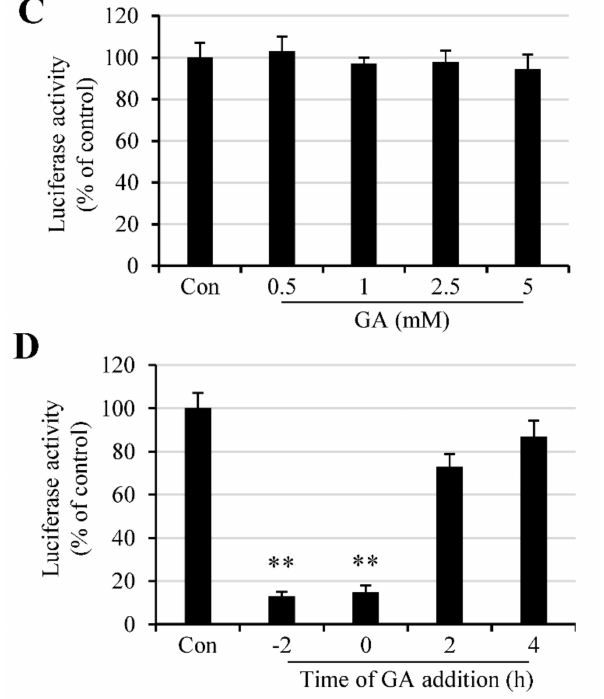
Figure 1. GA effect on Lenti-S infection. ( A ) Molecular structure of glycyrrhizic acid. ( B ) Effect of GA on Lenti-S infection. Vero E6 cells were infected with Lenti-S pseudovirus in the absence or presence of GA at indicated concentrations for 24 h. Luciferase activity was determined. Data are expressed as a percentage of untreated controls (Lenti-S). The experiment was performed twice, and data are mean ± SD of triplicate wells. Independent two-sample comparisons between non-GA treated sample and sample treated with GA at different concentrations, respectively, were determined by Student’s t test. ns: no significance; *, p < 0.05; **, p < 0.01. ( C ) Effect of GA on luciferase expression in pCMV-luc-transfected cells. Monolayers of 293T cells were transfected with pCMV-luc for 16 h. The cells were then treated with GA at indicated concentrations. Luciferase activity was determined after 24 h incubation. GA treatment did not affect luciferase expression delivered by an encoding plasmid. The experiment was performed twice. The readings from untreated samples were used as a control for the calculation of relative luciferase activity. Data are mean ± SD of duplicate wells from 2 independent experiments. ( D ) Time of GA addition on Lenti-S-mediated luciferase gene delivery. Vero E6 cells were untreated or treated with 3 mM GA at 2 h prior to ( − 2 h), during (0), or at 2 and 4 h post Lenti-S infection. Luciferase activity was determined 24 h PI. The experiment was performed 2 times. Data from the untreated controls were used for the calculation of relative luciferase activity. **, p <